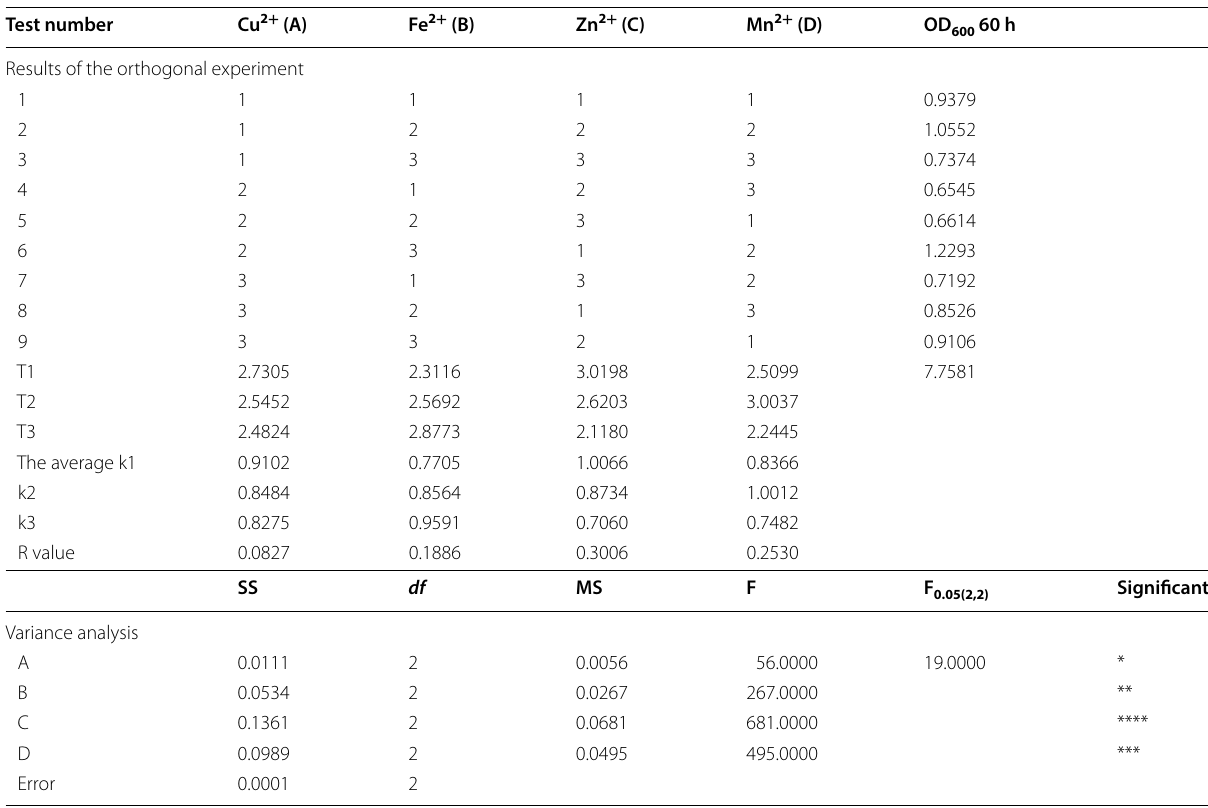
Table 2 Optimal concentration combinations of four trace elements affecting the proliferation of Paenibacillus polymyxa